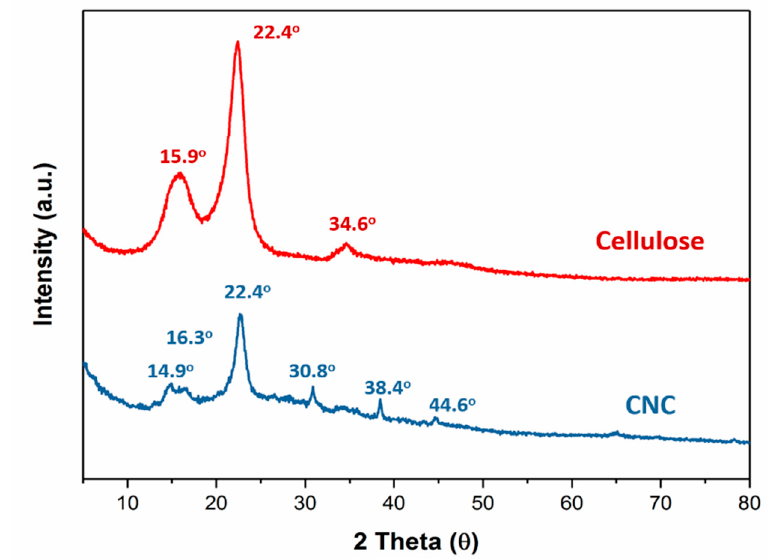
Figure 4. XRD patterns of pristine cellulose, CHC, GO and CHC/GO/CNC.